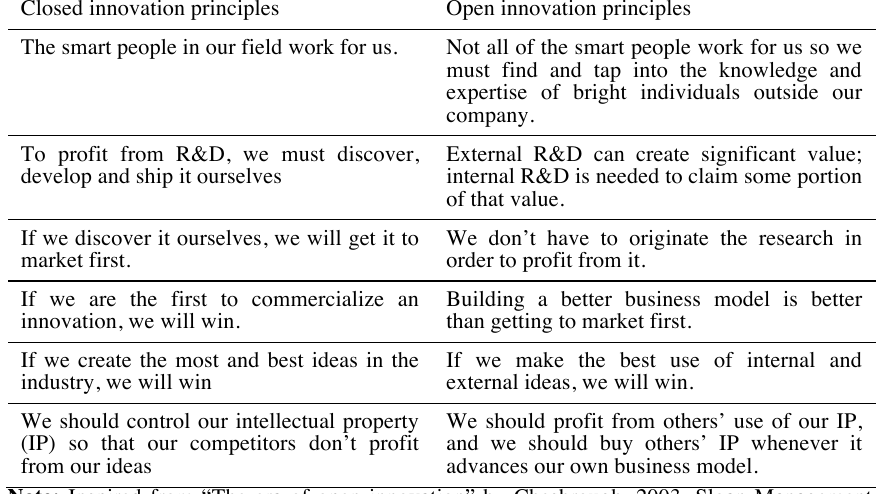
Table 1. Contrasting principles of closed and open innovation Closed innovation principles Open innovation